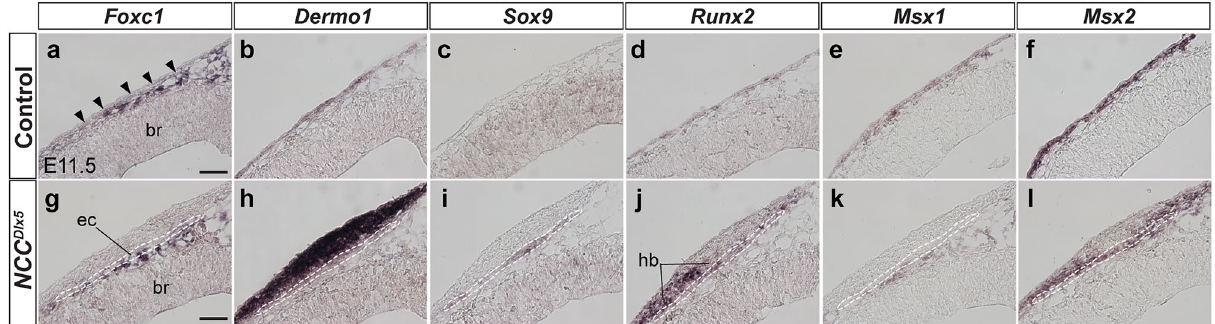
Figure 6. Gene expression patterns in the EMM at E11.5. Expression pattern of Foxc1- meningeal marker ( a , g ), Dermo1 -dermal marker ( b , h ), Sox9 -chondrocyte marker ( c , i ), Runx2 -osteoblast marker ( d , j ), and osteogenic regulators: Msx1 ( e , k ), Msx2 ( f , l ) on frontal sections of E11.5 control ( a – f ) and NCC Dlx5 (g–l) by ISH. Arrowheads in ( a ) point cells under the epidermis that weakly express Foxc1 . Foxc1 and Dermo1 demonstrate complementary expression in head mesenchyme in the control ( a , b ), Dermo1 and Runx2 are co-expressed in a thin cell layer under the epidermis ( b , d ). Msx1 is expressed in the whole head mesenchyme ( e ), while Msx2 is mainly expressed at the outer layer of head mesenchyme ( f ). In the NCC Dlx5 , Sox9